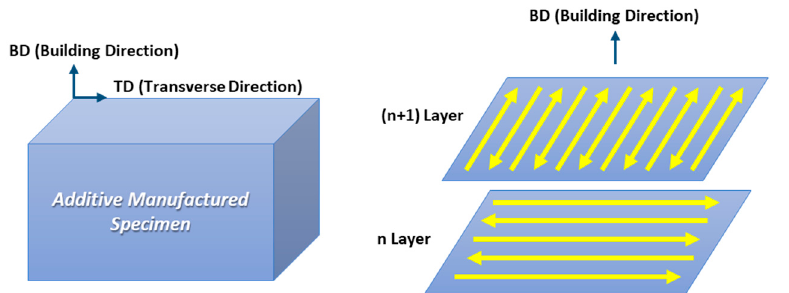
Figure 1. Schematic illustration showing the direction of the observation plane and scanning strategy in the additively manufactured specimen. As depicted in Figure 1, the microstructures were analyzed in planes perpendicular to the transverse direction (TD) and building direction (BD), respectively.